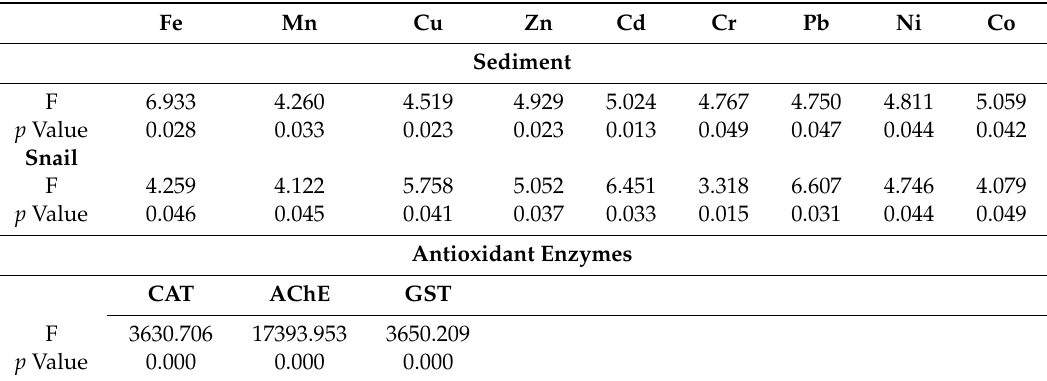
Table 2. F values and corresponding p values at 95% confidence intervals for metals and antioxidant enzyme activity in freshwater mollusk after one-way analysis of variance (ANOVA).